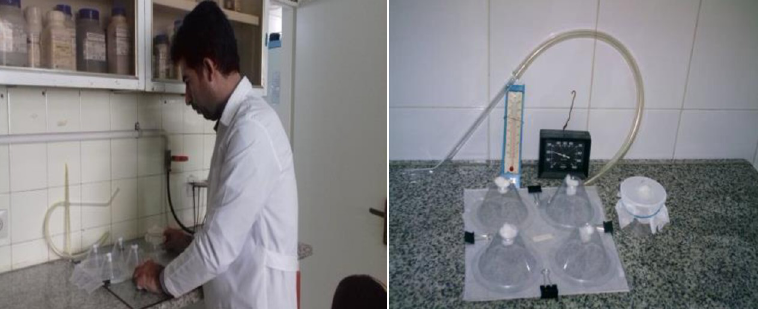
Fig 1. Bioassaytest to determine residual efficacyrate of ATSB-treated barrier fence in Markazi district, Qom province, Iran, 2015.